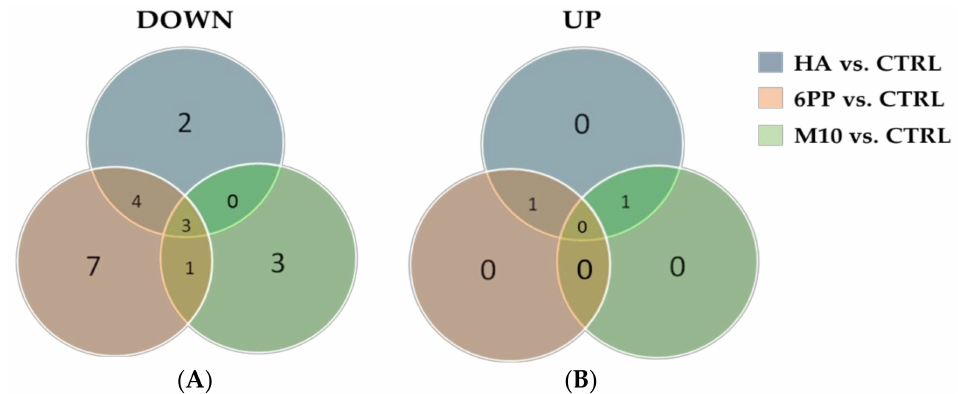
Figure 5. Venn diagrams of phenolic compounds whose abundance in the olive leaf metabolome ( A ) decreased (DOWN) or ( B ) increased (UP) compared to the control (CTRL). Data refer to metabolites extracted from plants treated with Trichoderma metabolites (HA and 6PP) or T. harzianum strain